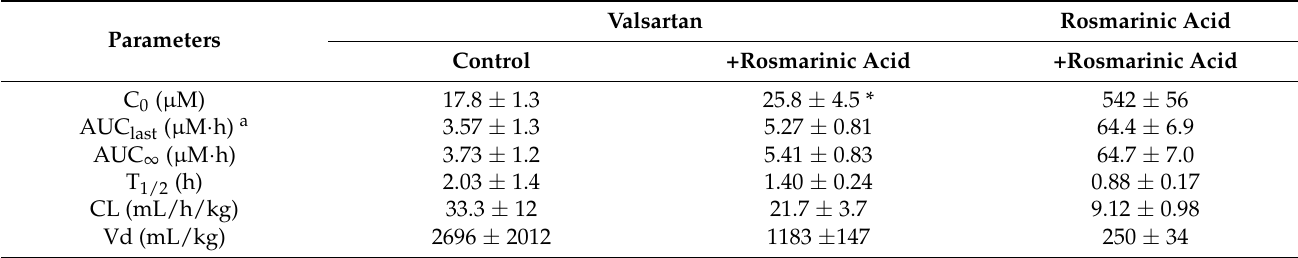
a AUC last : AUC from 0 to 6 h for valsartan and rosmarinic acid. * p < 0.05 compared with control group. Data expressed as mean ±